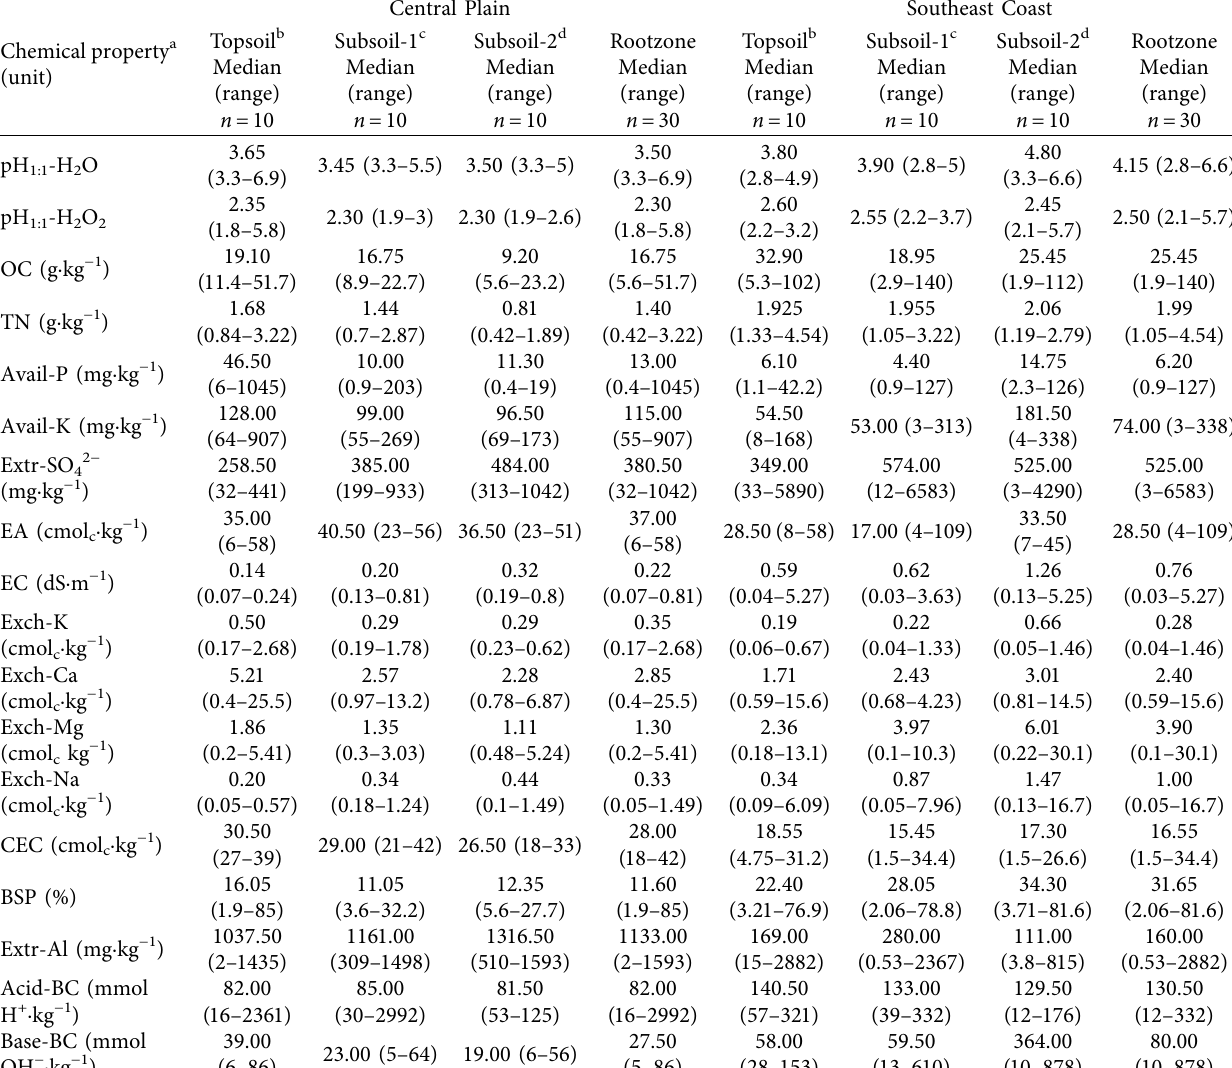
Table 7: Chemical properties of acid sulfate soils under oil palm planting areas in Central Plain and Southeast Coast. Chemical property